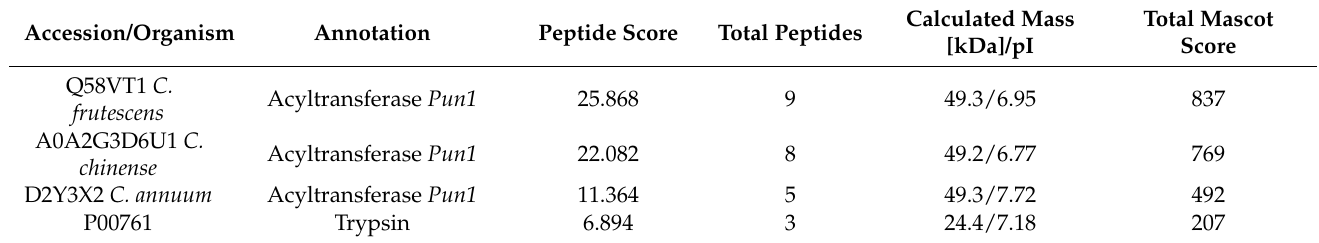
Table 1. Identification of capsaicin synthase purified by SDS-PAGE. Tryptic digest of band 2 (Figure 2) and sequence comparison against the SwissProt database revealed the highest mascot scores and highest peptide coverage to the proposed Pun 1 -encoded acyltransferases of C. frutescens , C. chinense , and C. annuum. Fragments of trypsin were the second most abundant peptides identified from the tryptic digest of this protein